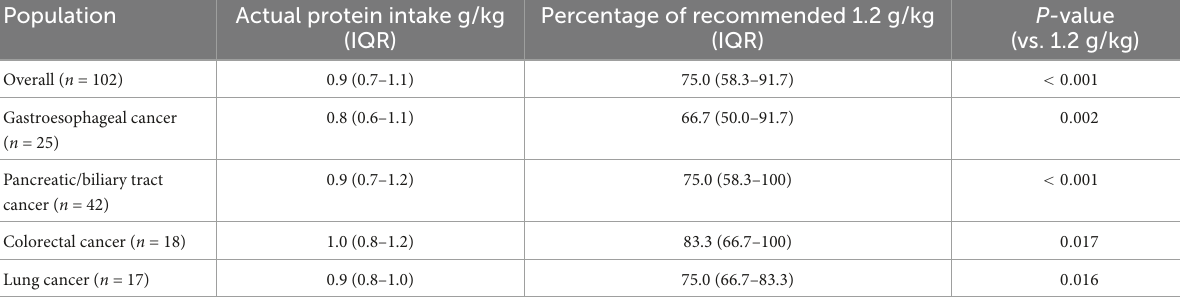
TABLE 3 Actual daily protein intake and European Society for Clinical Nutrition and Metabolism (ESPEN)/European Society for Medical Oncology (ESMO)-recommended protein intake.